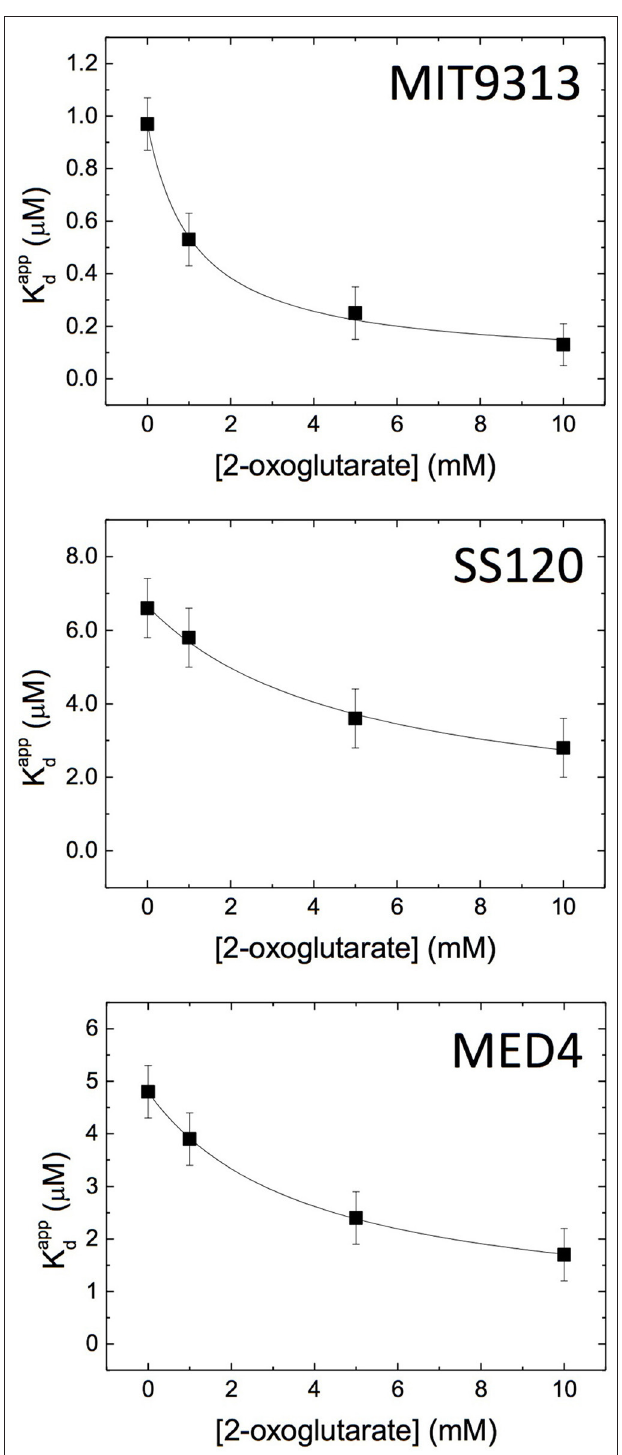
FIGURE 4 | Isothermal titration calorimetry study of the NtcA-P glnA interaction in the Prochlorococcus MED4, MIT9313 and SS120 strains. Apparent dissociation constant (K app d ) of the interaction of NtcA with the wild-type glnA promoter DNA was determined in the presence of different concentrations of 2OG. Further details are shown in Table 2